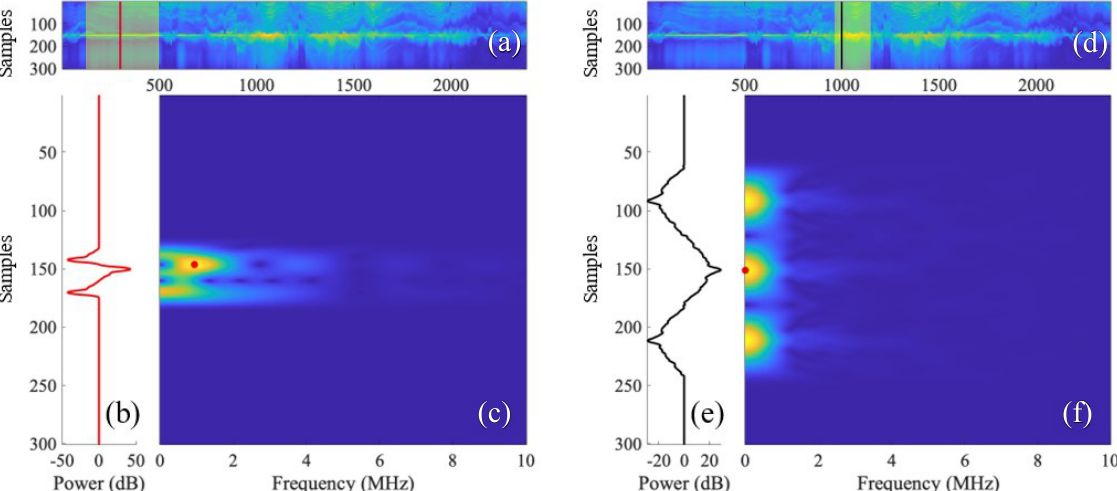
Figure 6. STFT results for the identification of different basal materials. ( a ) The banded B-scope in which the yellow box represents a distinct subglacial lake. ( b ) The reformed A-scope waveform at the position of the red line in ( a ). ( c ) The STFT result of the reformed A-scope in ( b ), where a non-zero-frequency response is denoted by a red dot for its maximum amplitude. ( d ) The banded B-scope in which the yellow box represents a bedrock region. ( e ) the reformed A-scope waveform at the position of the black line in ( d ). ( f ) The STFT result of the reformed A-scope in ( e ), where a zero-frequency response is denoted by a red dot for its maximum amplitude.